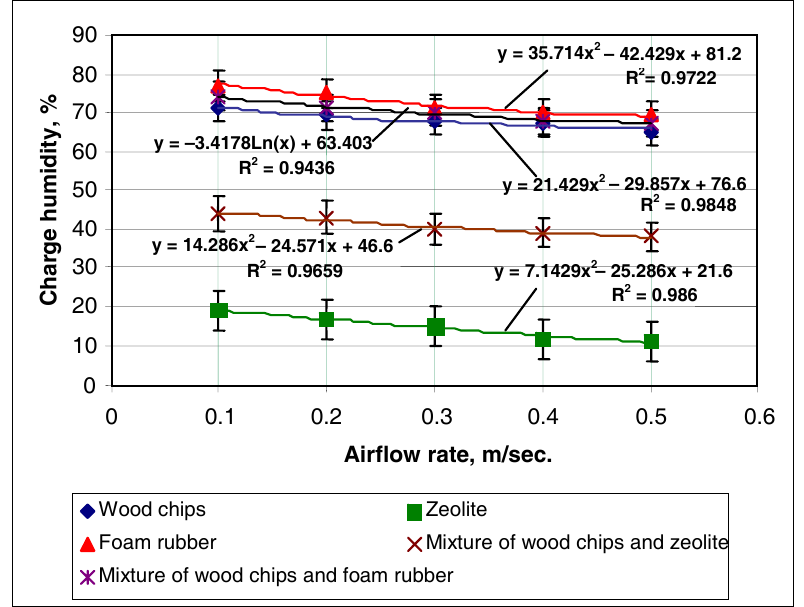
Fig 4. Dependence of the charge humidity on the airflow